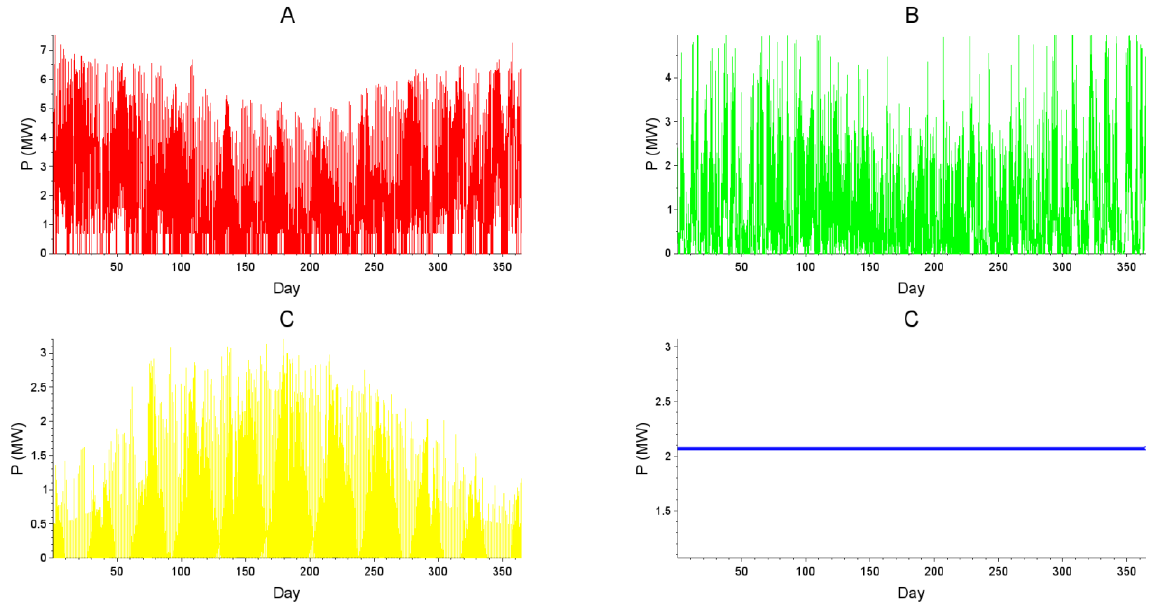
Figure 8. Demand coverage by electricity sources on exemplary days for RES power variant of 10 MW: ( A ) 4 January, and ( B ) 4 July.